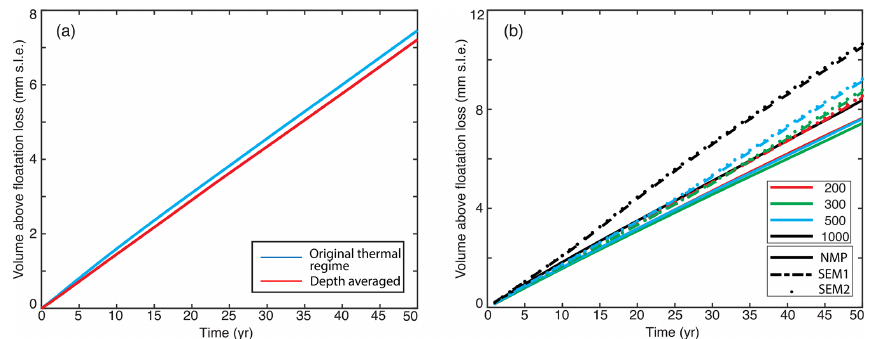
Figure A1. Volume above floatation loss in two sensitivity experiments (a) Exp. 160_1000_HO_Weertman_NMP with original thermal regime and its depth average. (b) Exp. 160_1000_SSA_Weertman with different ice shelf melt implementations and mesh